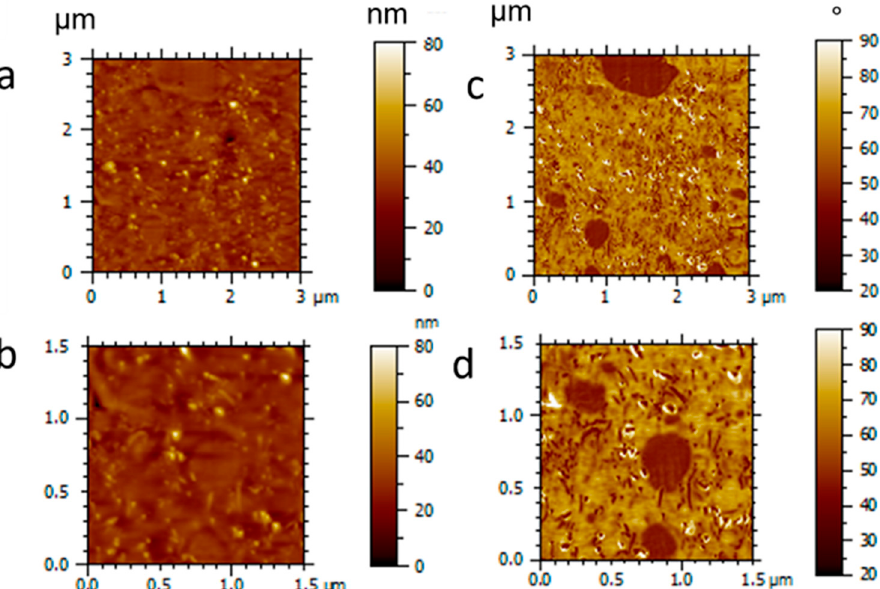
Figure 5. AFM images of the blend composite PEU70PLA30MWCNT14 (sizes 3 × 3 µ m 2 and 1.5 × 1.5 µ m 2 ; Images ( a , b ) are topography images, ( c , d ) are phase contrast images.